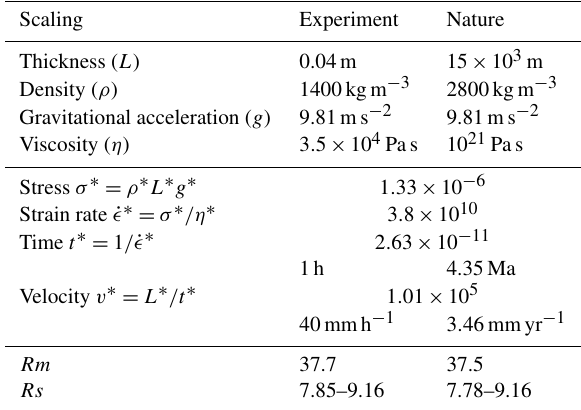
Table 2. Scaling between the model and nature. By convention, ra- tios ( ∗ ) are given as laboratory/nature. The Rm number is given for a velocity of 60mmh − 1 in the model (equivalent to 5.2mmyr − 1 in nature). The Rs number is given for a cohesion of 60–70Pa in the model and 45–53MPa in nature. Scaling Experiment